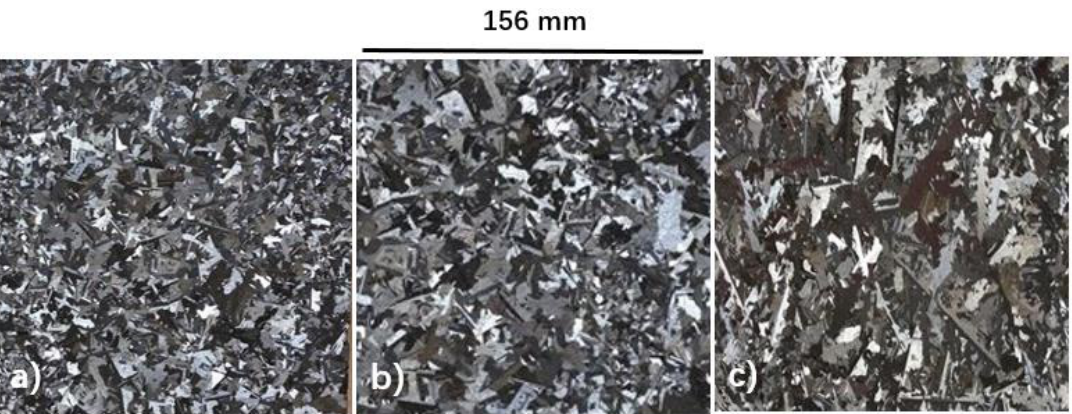
Figure 4. Optical photos of acid corrosion of the wafers. ( a ) Electrophoretic deposited quartz pow- der, ( b ) spray quartz powder, and ( c ) silicon